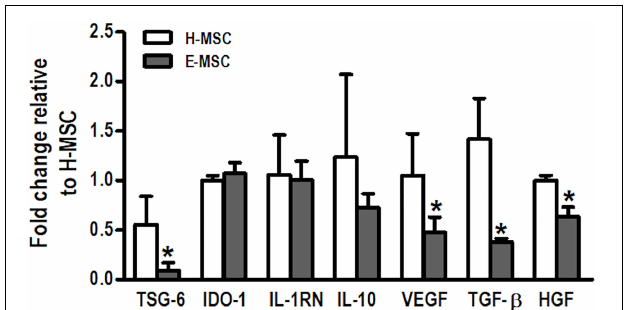
FIGURE 1 | Charaterization of mediators produced by MSCs from healthy and emphysematous donors. H-MSCs, bone marrow-derived mesenchymal stromal cells (BM-MSCs) obtained from healthy donors; E-MSCs, BM-MSCs obtained from emphysematous donors. Gene expression profile of tumor necrosis factor α -induced protein-6 (TSG-6), indoleamine 2,3-dioxygenase 1 (IDO-1), interleukin-1 receptor antagonist (IL-1RN), interleukin 10 (IL-10), vascular endothelial growth factor (VEGF), transforming growth factor β (TGF- β ), and hepatocyte growth factor (HGF) in H-MSCs and E-MSCs. Data are expressed as means ± standard deviation of 5–6 samples in each group. * P < 0.05 vs. the H-MSC group.